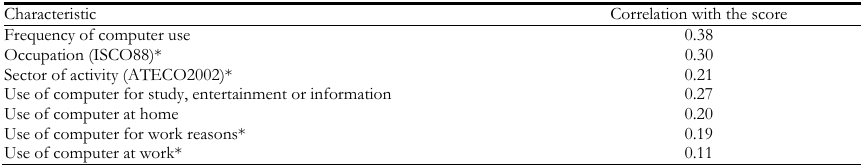
Canonical Correlation Results - Significant correlations (Ho : ρ = 0 rejected) Characteristic Correlation with the score Frequency of computer